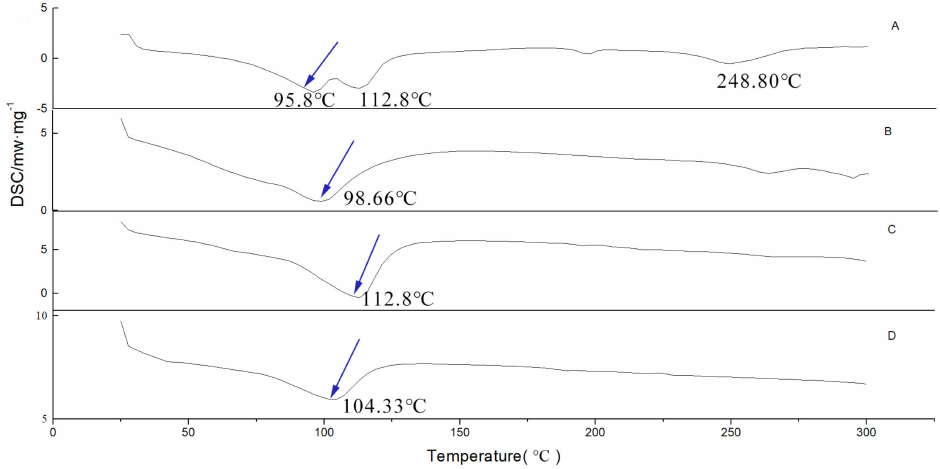
Figure 6. DSC thermograms of G-Re ( A ), γ -CD ( B ), G-Re- γ -CD PM ( C ), and G-Re- γ -CD IC ( D